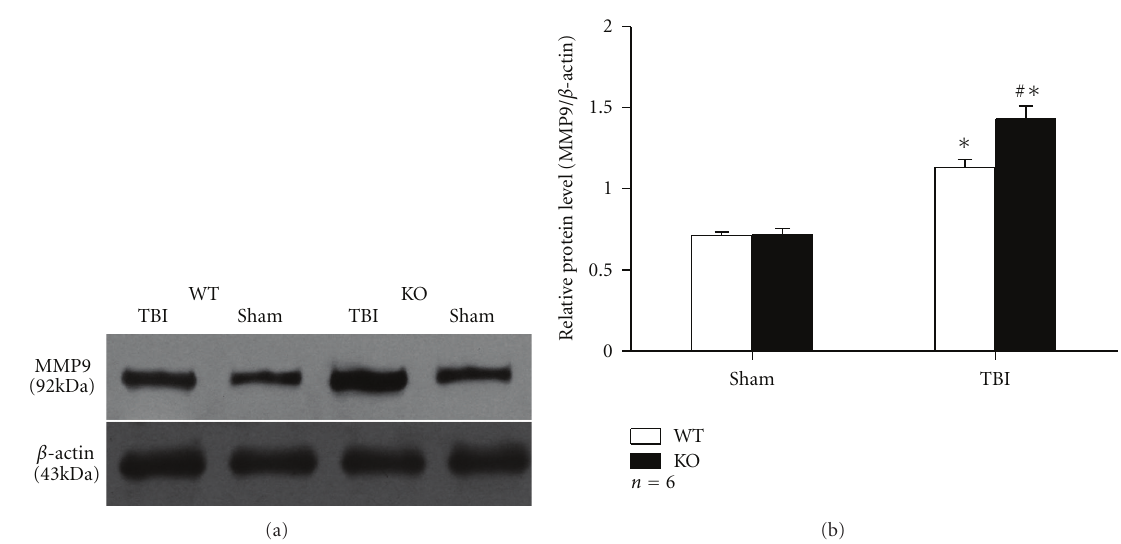
Figure 5: Western blot analysis of MMP9 protein level. (a) Western blot showed that protein level of MMP9 was elevated in astrocytes after scratch and was significantly higher in group KO TBI than in group WT TBI. (b) Quantitative analysis of western blot result showed that relative protein level of MMP9 was higher in astrocytes after scratch ( P < 0 . 01). Such elevation was much severe in group KO TBI than in group WT TBI ( P < 0 . 01). ( ∗ P < 0 . 01, compared with sham counterpart; # P < 0 . 01, compared with WT TBI).